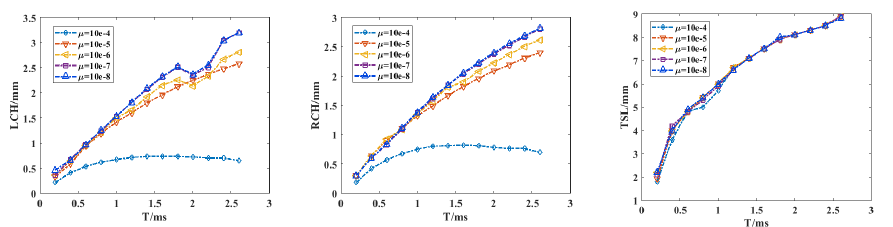
Figure 17. Crowns heights at different viscosity when θ = 30 ◦ .